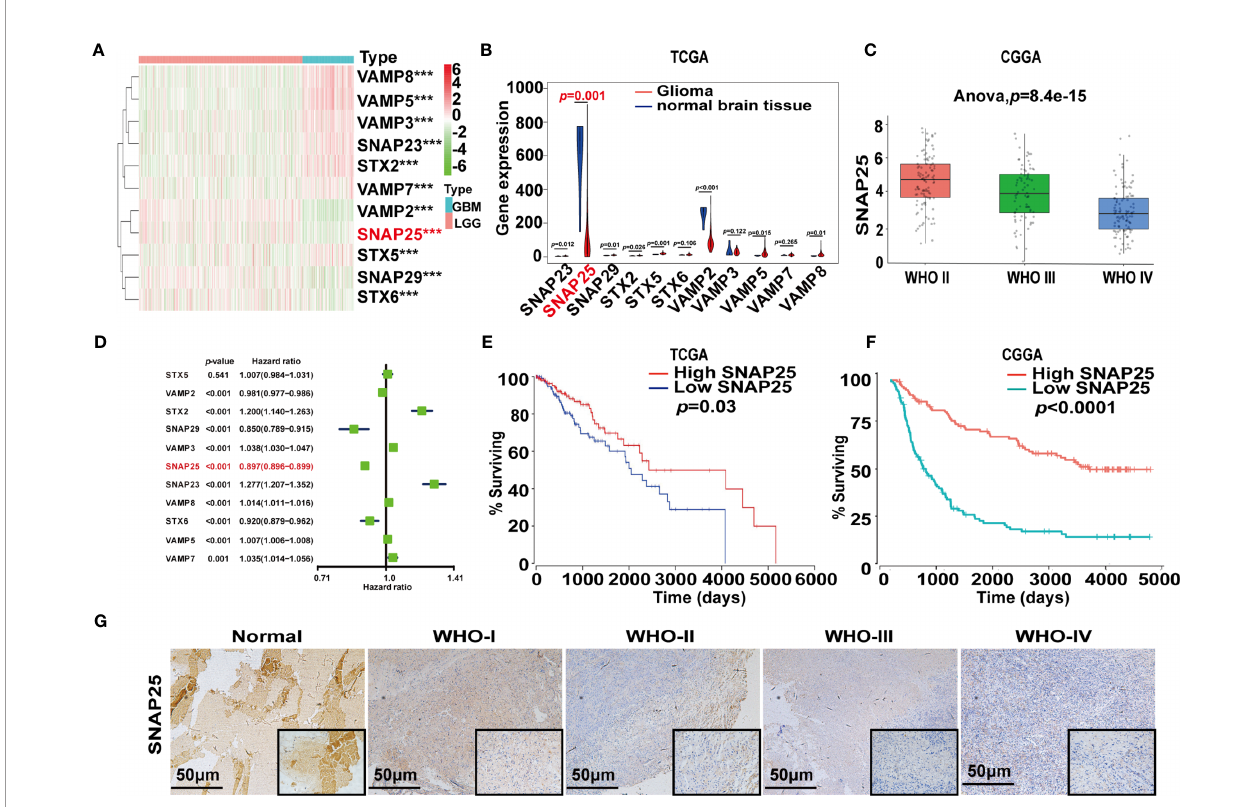
FIGURE 1 | SNARE-related genes expression pro fi les and correlation between gene expression and clinical features in TCGA and CGGA datasets. (A) Heatmap show the different expression levels of 11 SNARE-related genes in TCGA dataset. Up-regulation is shown in red and downregulation is in blue. *** p < 0.001. (B) Violin plot shows the expression of SNARE-related genes in normal tissue and gliomas. (C) Box plot shows SNAP25 expression in different glioma grades in CGGA database. (D) Hazard ratio values of the eleven selected genes. (E, F) Kaplan-Meier survival analysis for glioma patients with low and high risk scores in TCGA and CGGA datasets. Kaplan-Meier survival curve for glioma patients with a high risk score (red line) and a low risk score (blue line). (G) Representative images of SNAP25 expression from glioma tissues and nontumor tissues by ISH